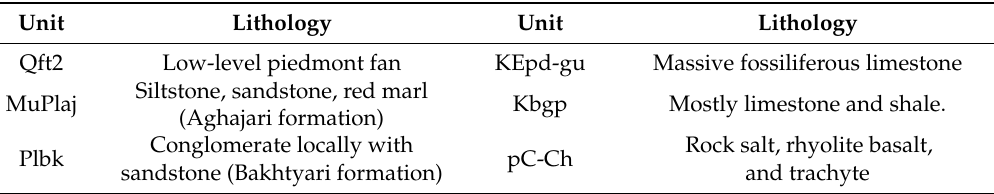
Figure 3. Groundwater e ff ective factors: ( a ) altitude; ( b ) slope angle; ( c ) slope aspect; ( d ) slope length plan curvature; ( e ) plan curvature; ( f ) profile curvature; ( g ) topographic wetness index (TWI); ( h ) distance to river; ( i ) drainage density; ( j ) lithology; ( k ) distance to fault; ( l ) fault density; ( m ) rainfall; ( n ) land use; and ( o ) soil. Table 1. Lithology characteristics of the Booshehr